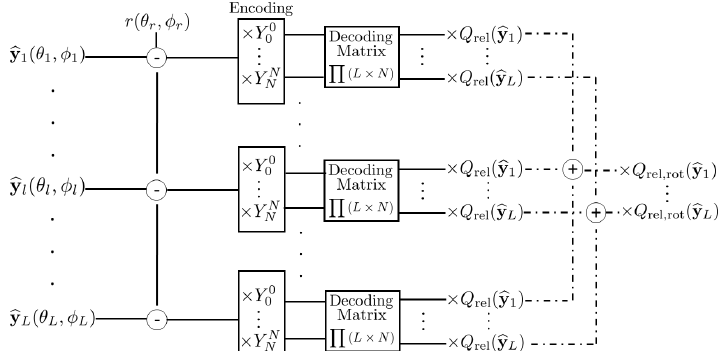
Figure 17. Rotation